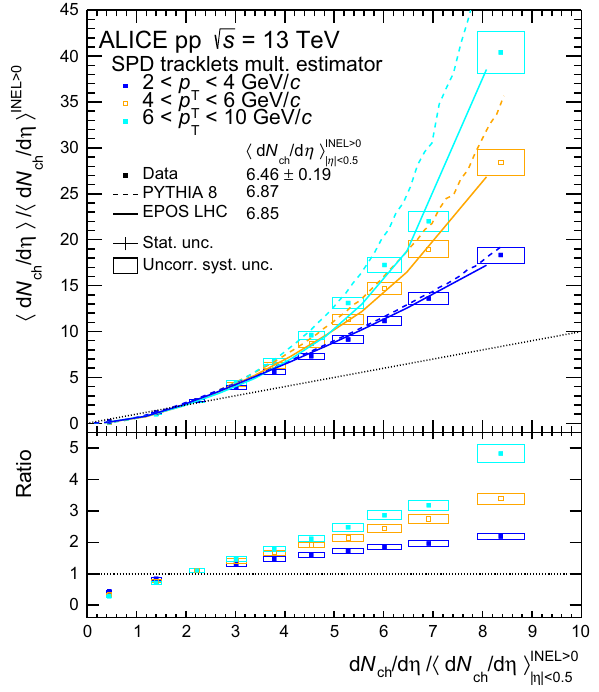
Fig. 6 Self-normalized yields of charged particles integrated over dif- ferent p T intervals: 2 < p T < 4GeV/ c , 4 < p T < 6GeV/ c , and 6 < p T < 10GeV/ c . The integrated yields for pp collisions at √ s = 13TeV are shown as a function of charged-particle density at mid-pseudorapidity. Statistical and uncorrelated (across multiplicity) systematic uncertainties are shown as error bars and boxes around the data points, respectively. Statistical uncertainties are negligible com- pared to systematic uncertainties. Data are compared with PYTHIA 8 (dashed lines) and EPOS LHC (solid lines). The dotted line is drawn to see the differences between data and the linear dependence. Deviations of data from the linear trend are shown in the bottom